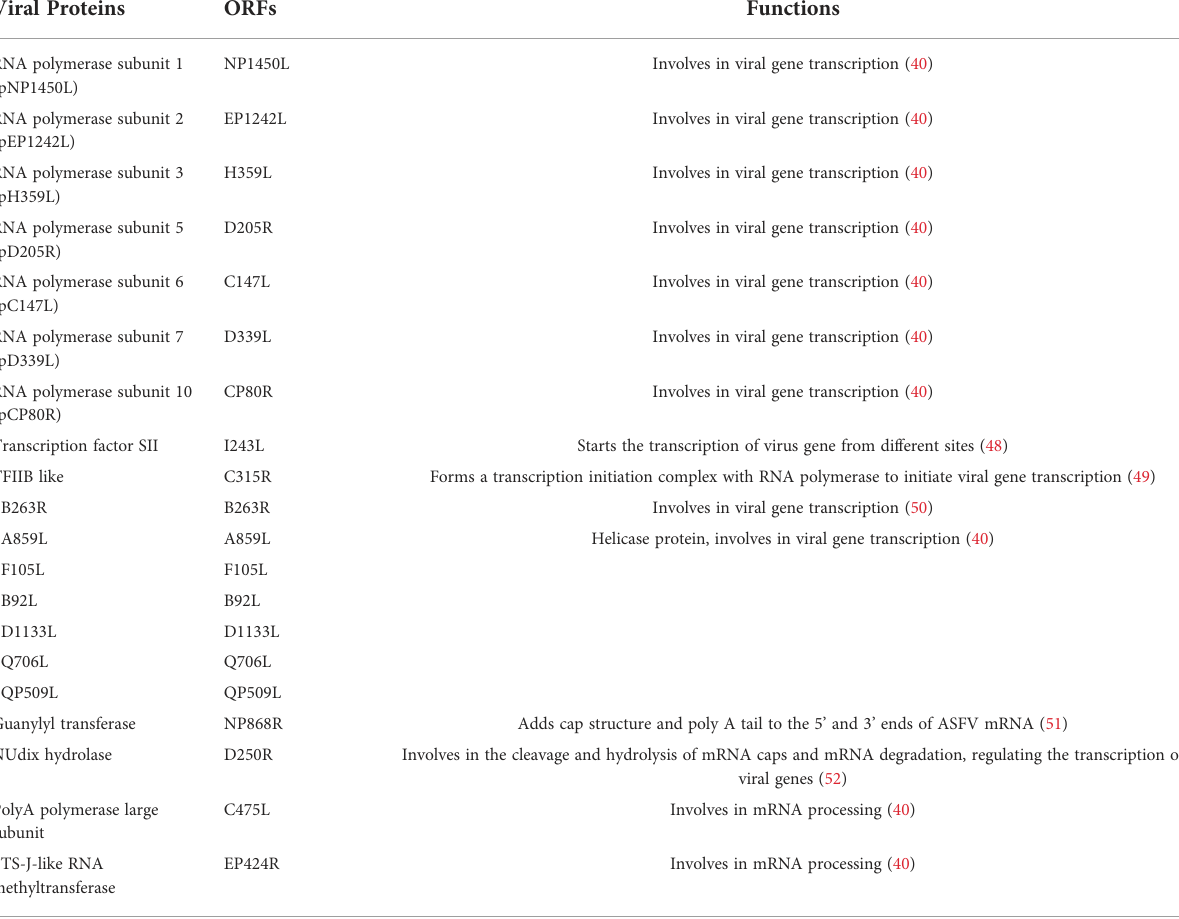
TABLE 3 ASFV encodes related proteins involved in genome transcription. Viral Proteins